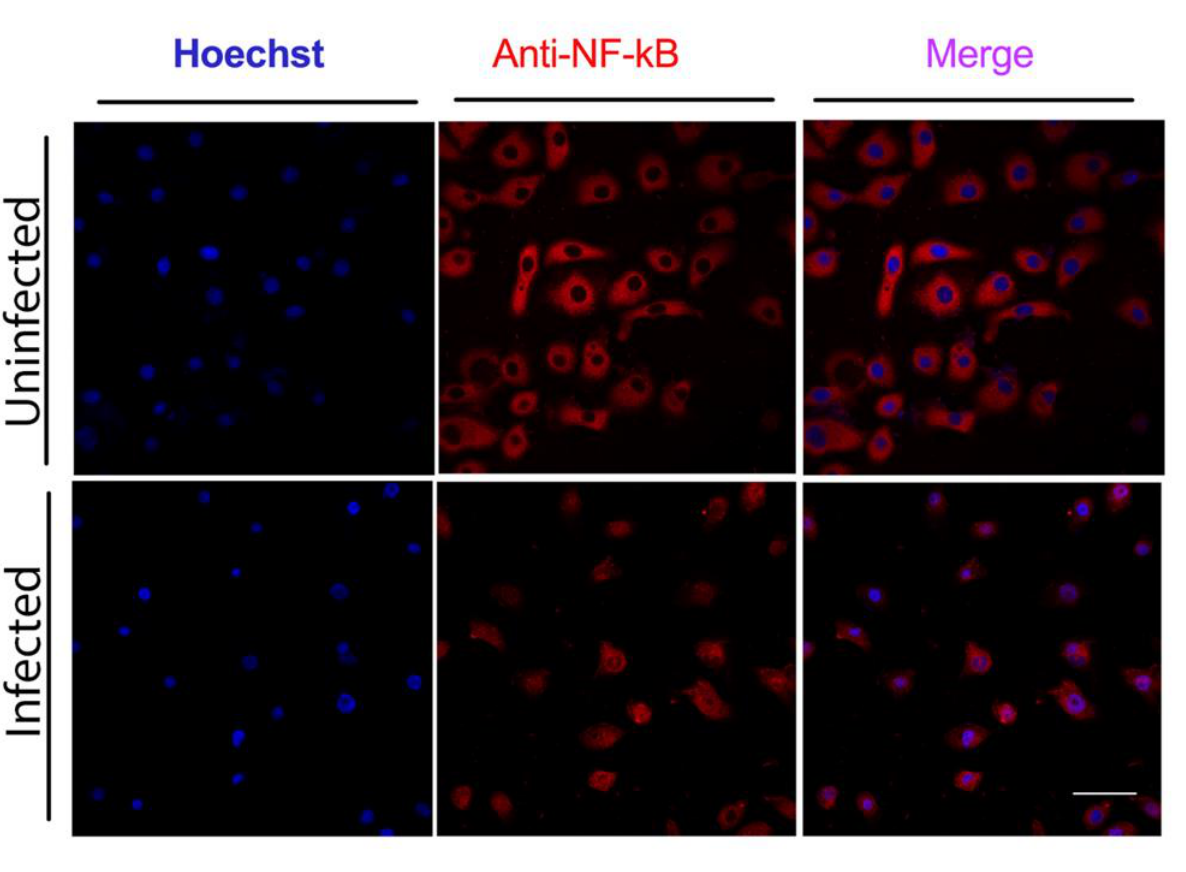
FIGURE 3: Activation of NF- κ B in hGECs infected with C. pneumoniae . hGECs were infected with C. pneumoniae at a MOI of 5 for three days and immunocytochemistry performed using a NF- κ B/p65 monoclonal antibody (red). hGEC cell nuclei were counterstained with Hoechst